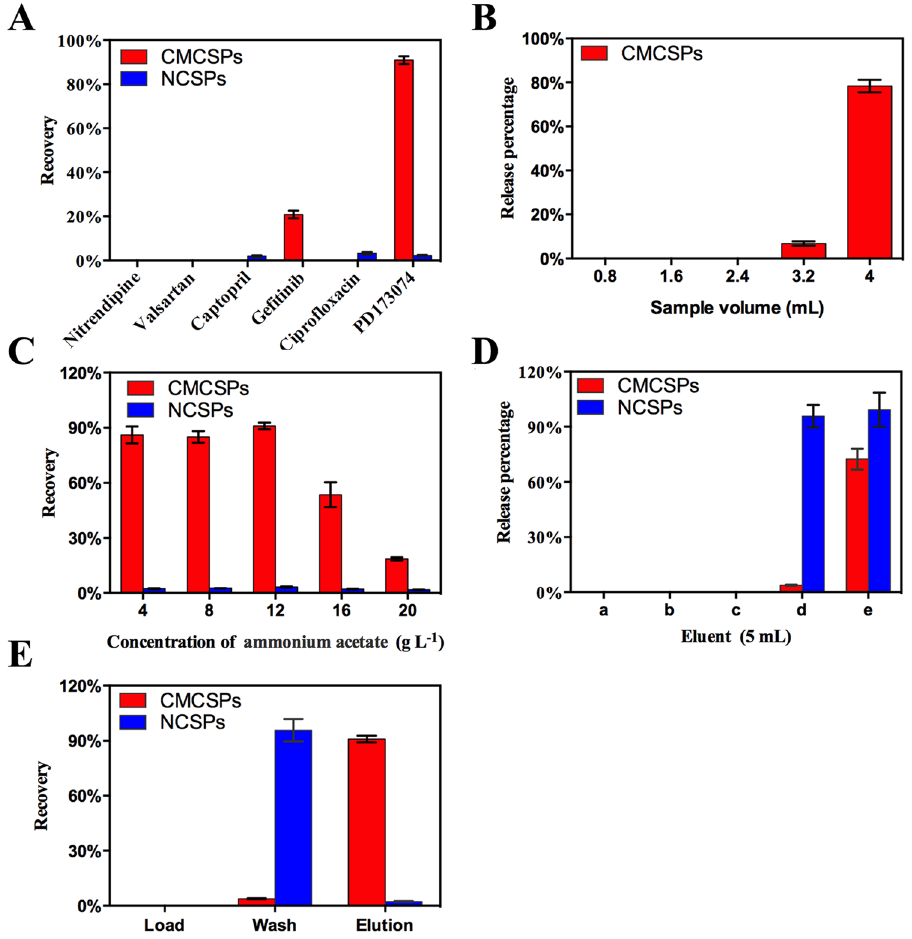
Figure 4. ( A ) Elution recoveries obtained of kinds of medicines acting on different type of receptors; ( B ) Release percentage of PD during the loading step with different sample volume; ( C ) Selection of ionic strength; ( D ) Selection of eluent: water (a), 4 g L − 1 ammonium acetate buffer solution (b), 12 g L − 1 ammonium acetate buffer solution (c), isopropyl alcohol-12 g L − 1 ammonium acetate buffer solution (1:99, v/v) (d) and isopropyl alcohol-12 g L − 1 ammonium acetate buffer solution (5:95, v/v) (e); ( E ) Recoveries obtained from FGFR4/ CMCSPs SPE and NCSPs SPE of PD (5 μ g mL − 1